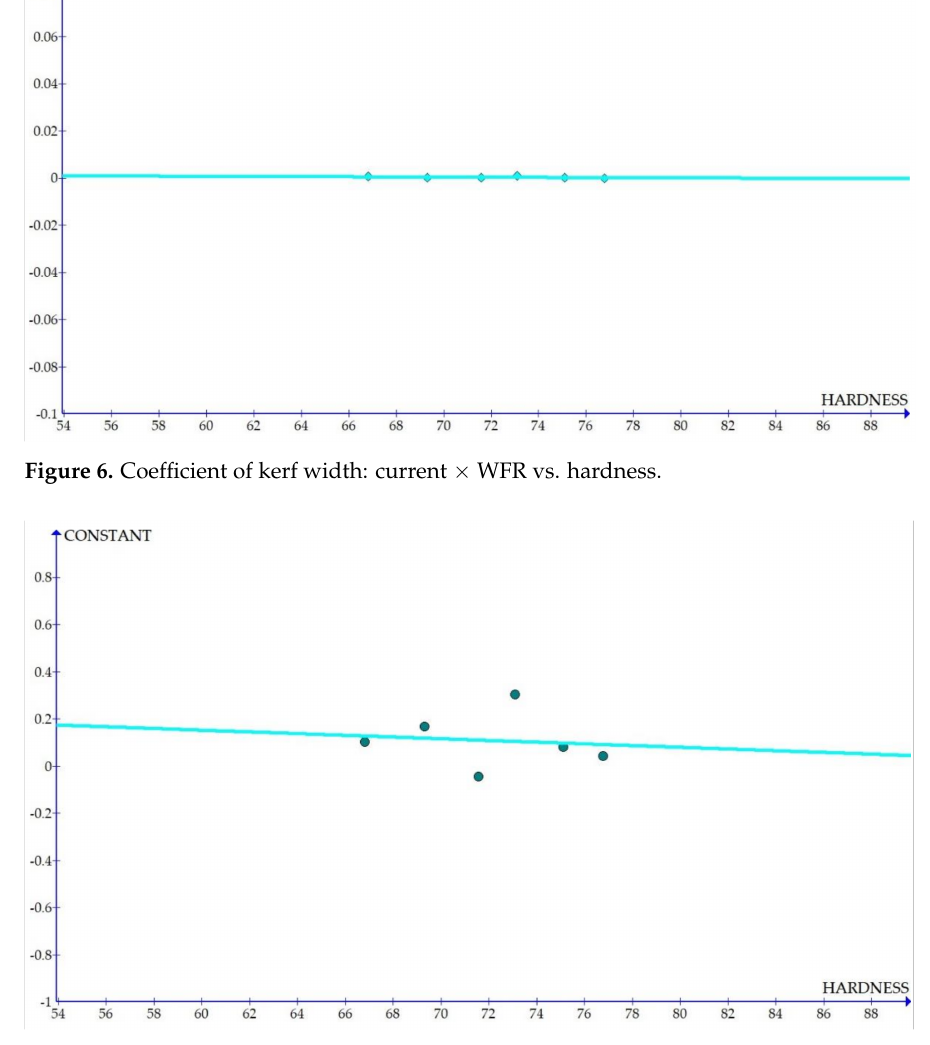
Figure 7. Coefficient of kerf width: constant vs.